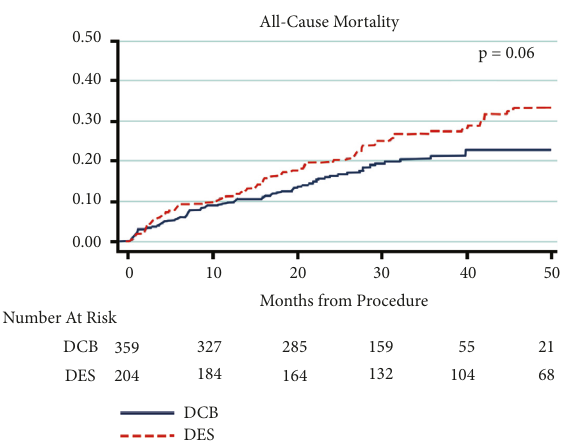
Figure 7: Mortality between DES and DCB. No clinically signif- icant difference in mortality observed between the two groups. DCB � drug-coated balloons; DES � drug-eluting